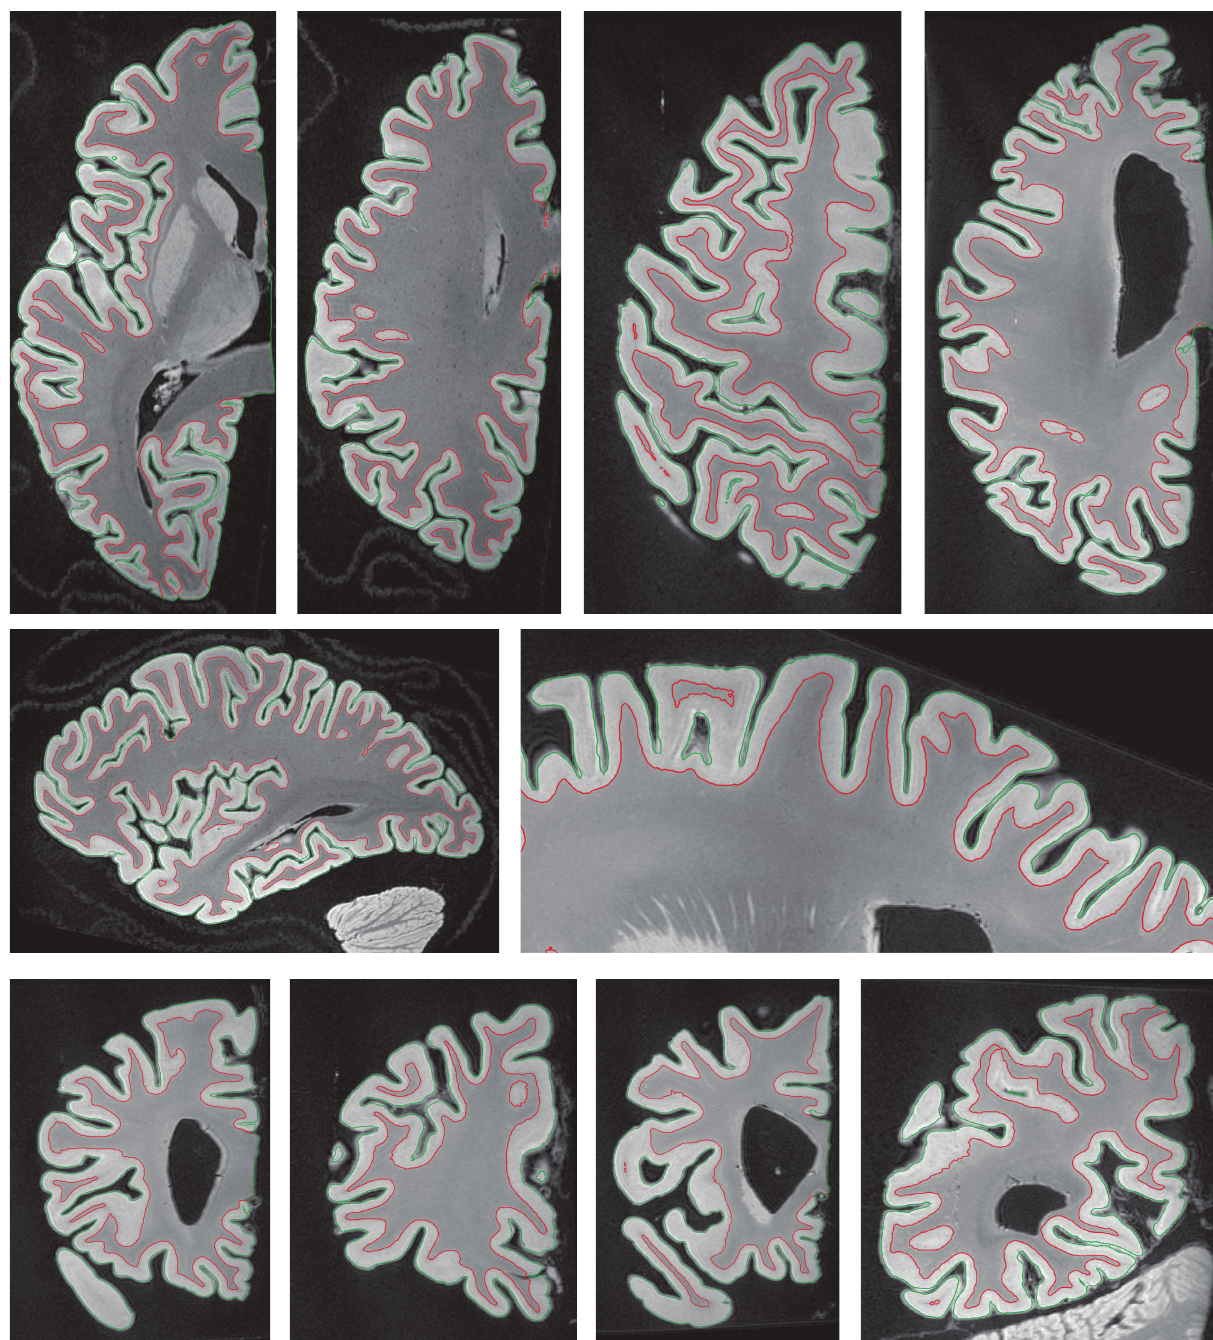
Figure 6: Isocontours of the zero level sets of reconstructed cortical surfaces overlaid on cross-sections of high-resolution MR images (red: the inner surface; green: the outer surface; top, middle, and bottom rows: examples of axial, sagittal, and coronal sections (not to scale),